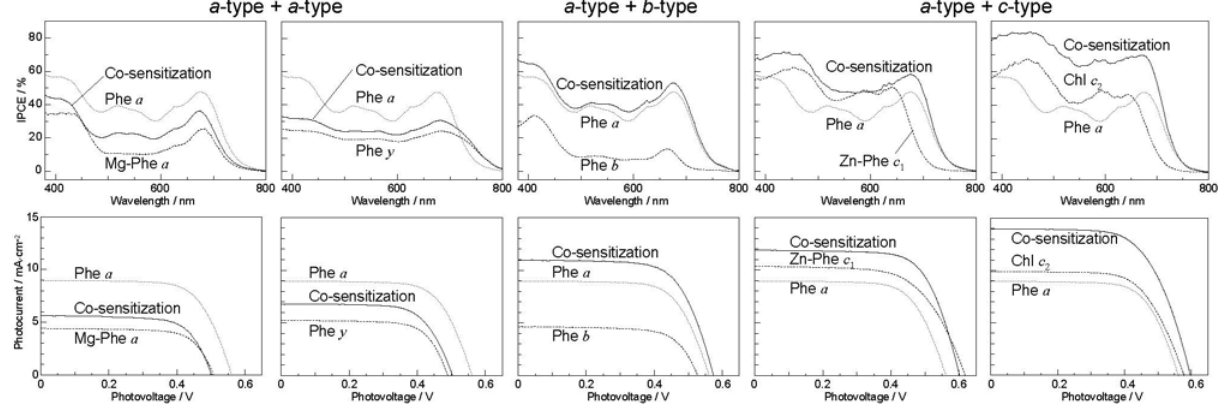
Figure 44. The IPCE profiles (upper panels) and the I–V curves (lower panels) for three different types of